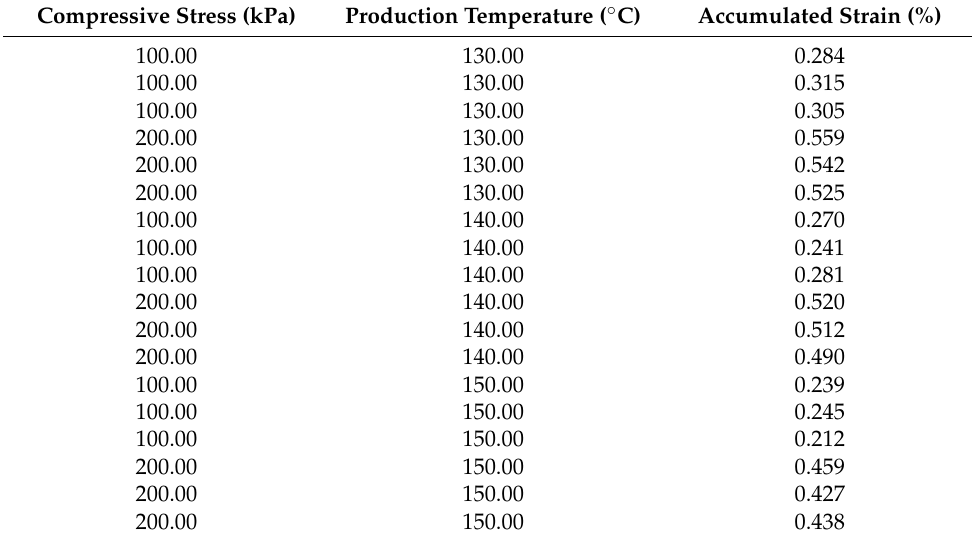
Table 7. Input data of the accumulated strain model.